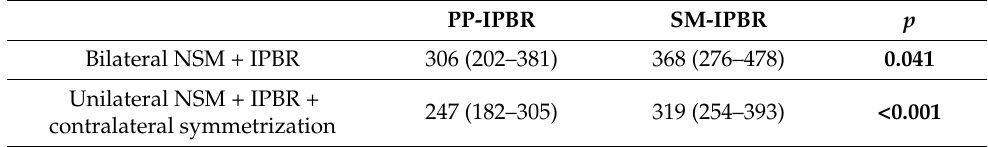
Table 4. Operative time (minutes).